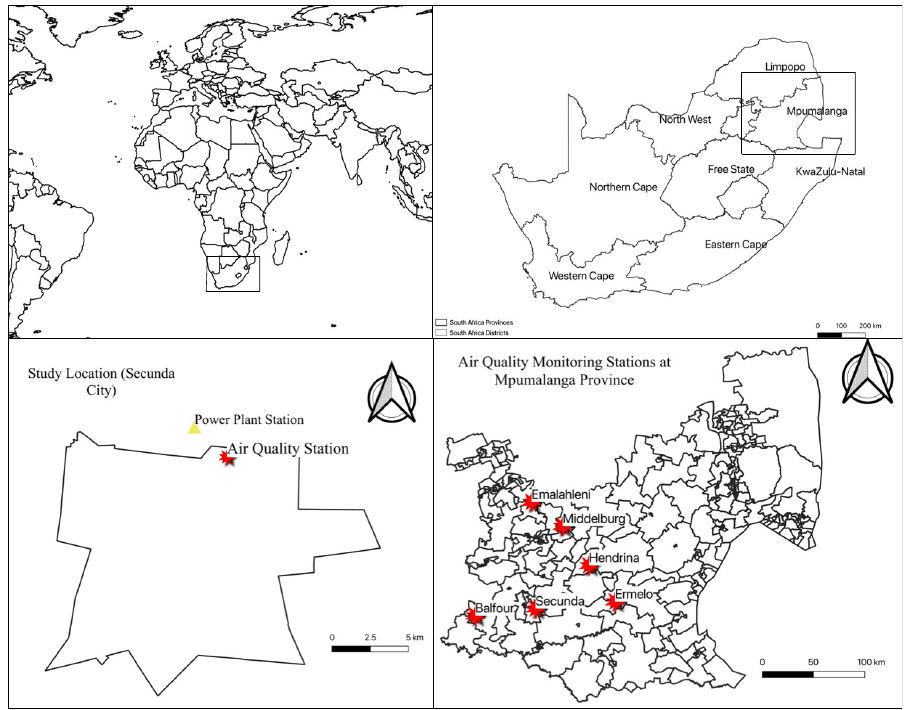
Figure 1. The location of Secunda in Mpumalanga province of South Africa. The red star shows the location of the air quality monitoring stations, the yellow triangle shows the coal-fired power plant, and the black-dot shows the location of the coal mines.